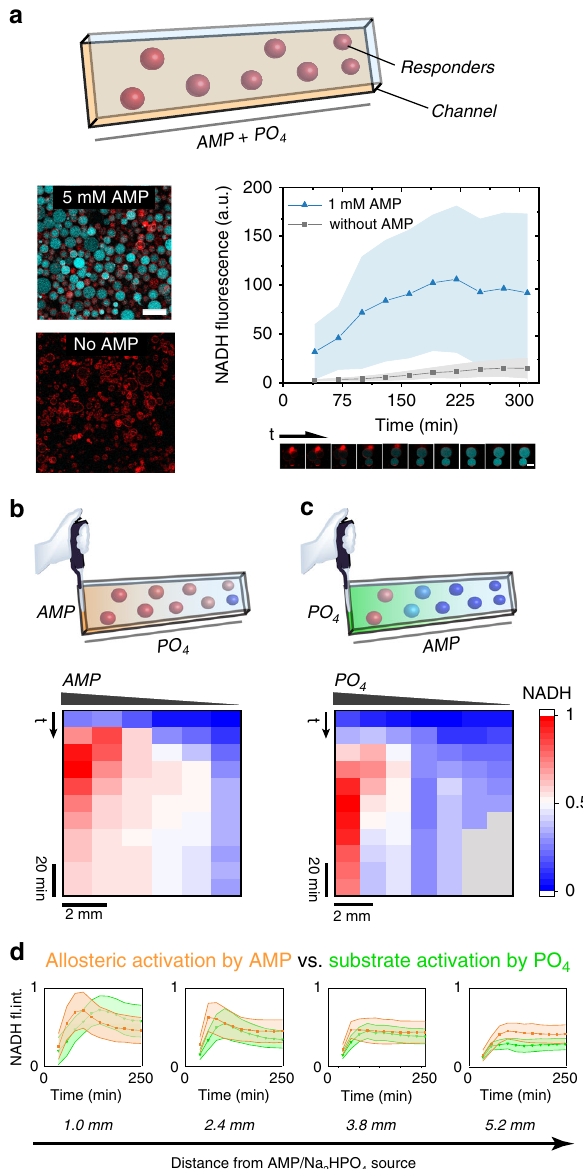
Fig. 3 Activation of Receiver GUVs and the effect of signal ampli fi cation. a Receiver GUVs were incubated with solutions of either AMP and Na 2 HPO 4 or Na 2 HPO 4 alone. The activation of the Receivers was monitored by time-lapse CLSM, which tracked the production of fl uorescent NADH (cyan). Receiver GUVs were labelled with DOPE- (Lissamine Rhodamine B) (red). When Receiver GUVs were incubated with AMP their Response Cascade was activated, whereas in absence of AMP the Receivers did not activate. Scale bars represent 50 µ m. Error bars